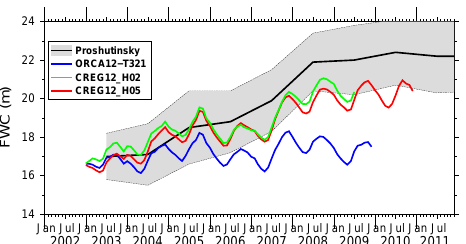
Figure 9. Time series of the estimated liquid freshwater content, av- eraged over the Beaufort Gyre, from Proshutinsky et al. (2009) and updates (black with uncertainties overlaid as grey area and bounded by dashed lines) compared with estimates from the ORCA12- T321 run from Mercator Océan (blue) and CREG12 hindcasts H02 (green) and H05 (red).